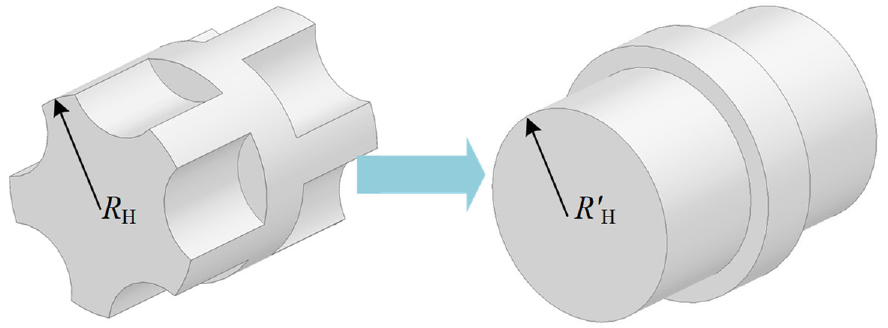
Figure 10. The key parameters and magnetic equivalent circuit of the HTR-ASD.